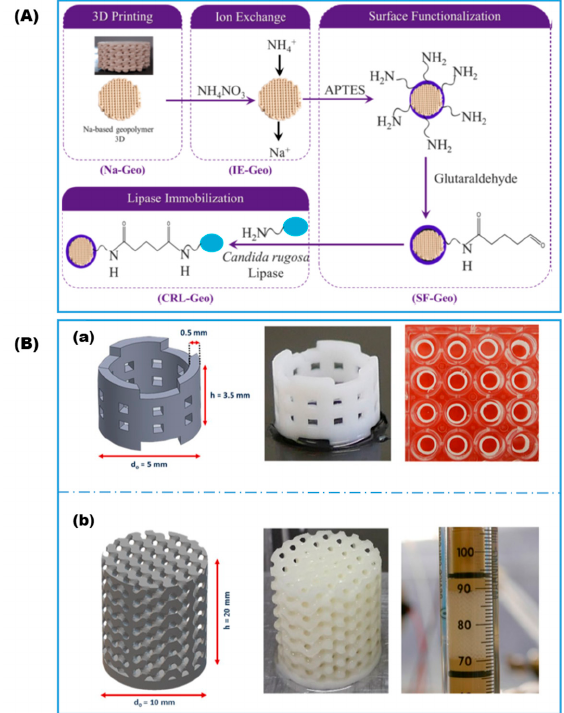
Figure 4. ( A ) Protocols for immobilizing lipase on 3D printed geopolymer lattices (Reproduced with permission from Ref. [58]). ( B ) Porous monoliths reaction beds for bioprocess engineering: ( a ) hollow cylinder that fits in the wells of a 96 multi-well plate for batch testing and ( b ) gyroid scaffold that fits in reactor column for dynamic testing (reproduced with permission from Ref.